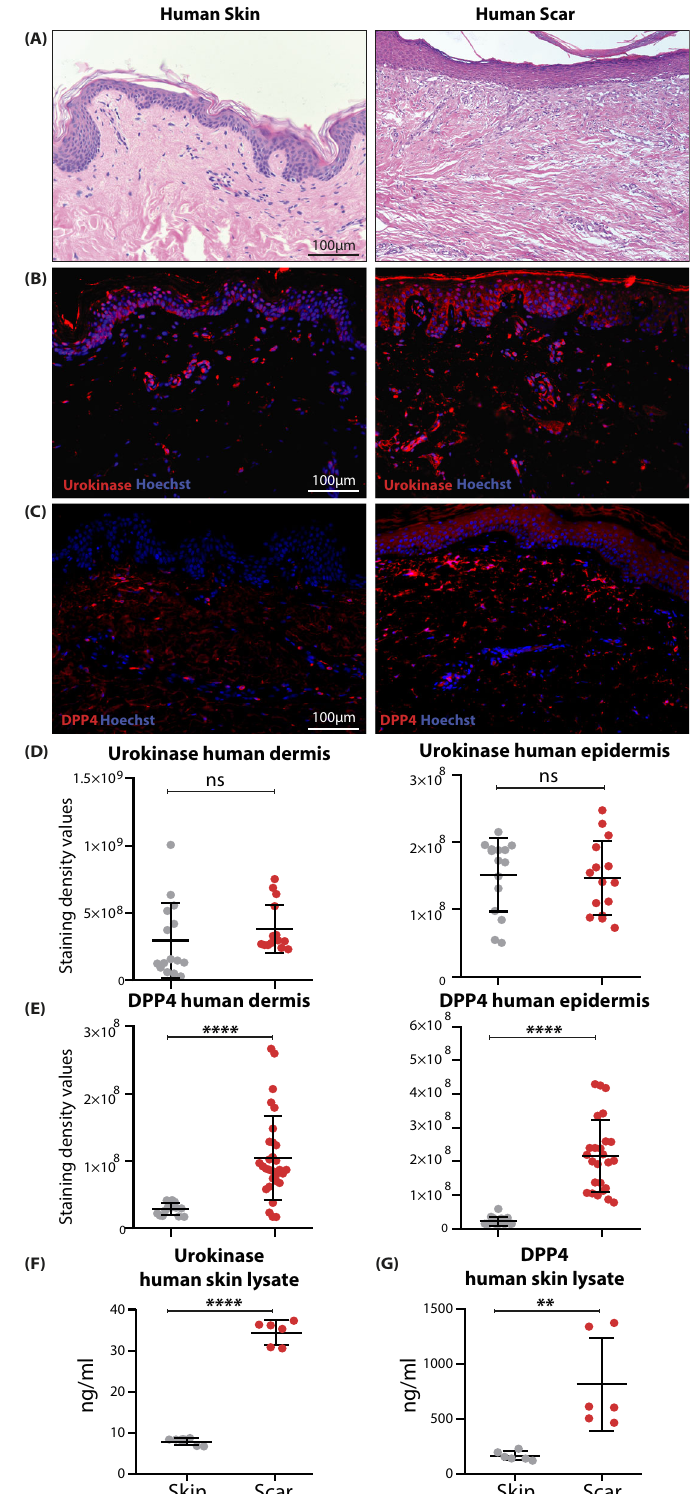
Fig. 6 Immuno fl uorescence staining con fi rms elevated expression of PLAU and DPP4 in human and mouse skin and scar. A H&E staining of human skin and scar; immuno fl uorescent staining of B Urokinase and C DPP4 in human skin and scar. Quanti fi cation of staining intensity separate for epidermis and dermis for D urokinase ( p = 0.329 dermis, p = 0.815 epidermis) and E DPP4 ( p < 0.0001 dermis, p < 0.0001 epidermis). For all stainings, n = 2 – 3 normal skin samples were analyzed, and n = 4 scars. From each sample, fi ve regions of interest per sample were quanti fi ed. ELISA from human whole skin ( n = 6) and scar ( n = 6) lysate for F urokinase ( p < 0.0001) and G DPP4 ( p = 0.0037) is shown. Statistical signi fi cance was tested using two-tailed unpaired Student t -test. Lines and error bars indicate mean and standard deviation. NS p > 0.05, * p < 0.05, ** p < 0.01, *** p < 0.001. Source data are provided as a Source data fi